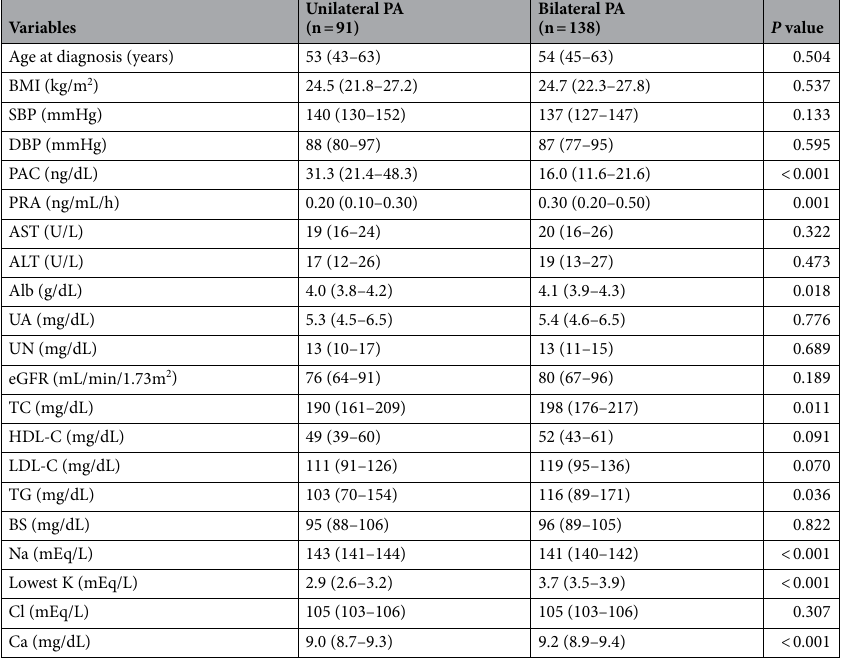
Table 1. Clinical characteristics of 229 patients with unilateral and bilateral subtypes in the modeling primary aldosteronism cohort. Data are expressed as medians with interquartile ranges or number with percentage. PA indicates primary aldosteronism; BMI, body mass index; SBP, systolic blood pressure; DBP, diastolic blood pressure; PAC, plasma aldosterone concentration; PRA, plasma renin activity; AST, aspartate aminotransferase; ALT, alanine aminotransferase; Alb, albumin; UA, uric acid; UN, urea nitrogen; eGFR, estimated glomerular filtration rate; TC, total cholesterol; HDL-C, high density lipoprotein cholesterol; LDL-C, low density lipoprotein cholesterol; TG, triglyceride; BS, blood sugar; Na, sodium; K, potassium; Cl, chlorine; Ca, calcium.